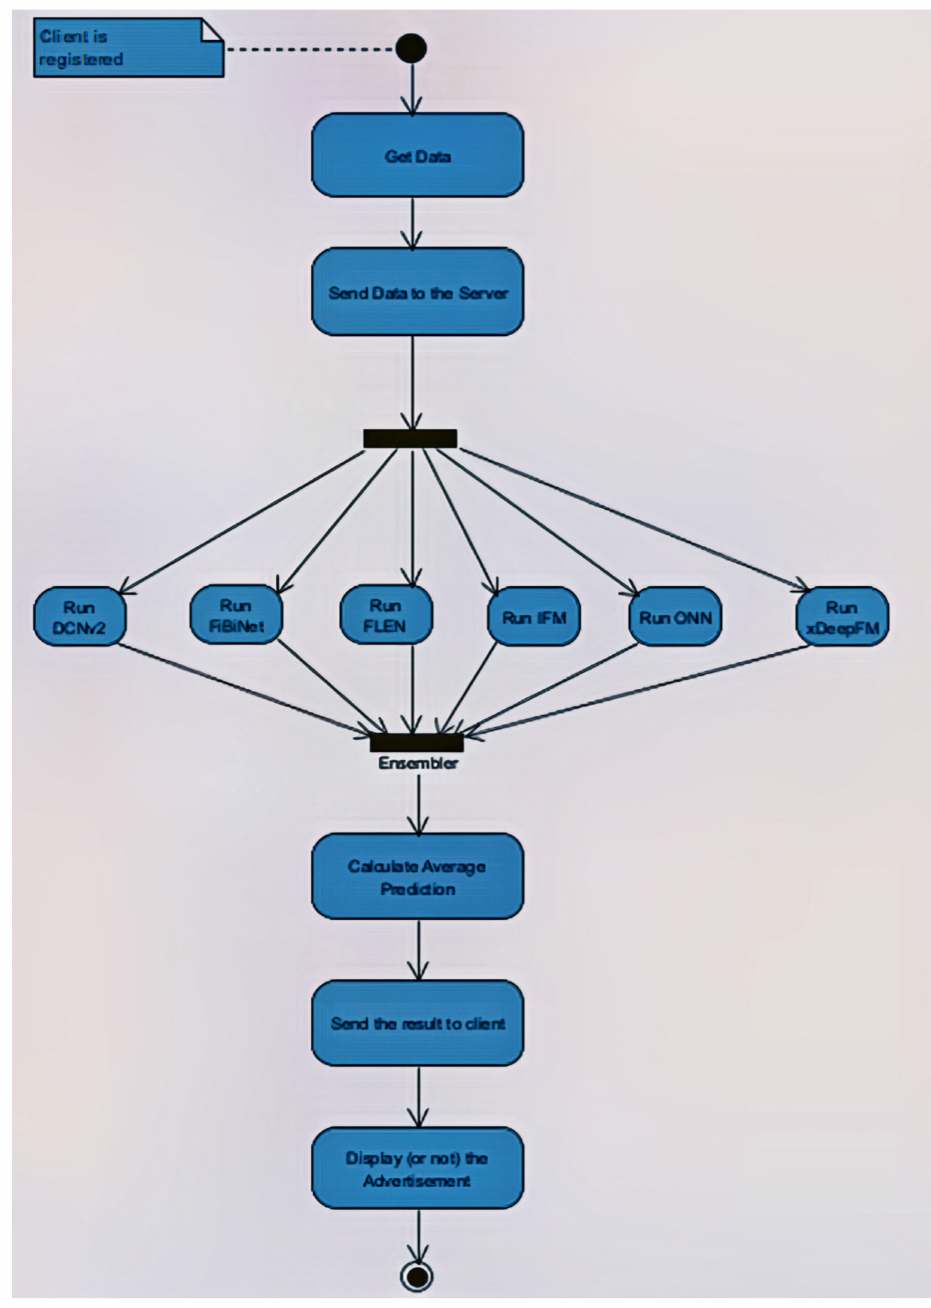
Figure 5. Implementation–development